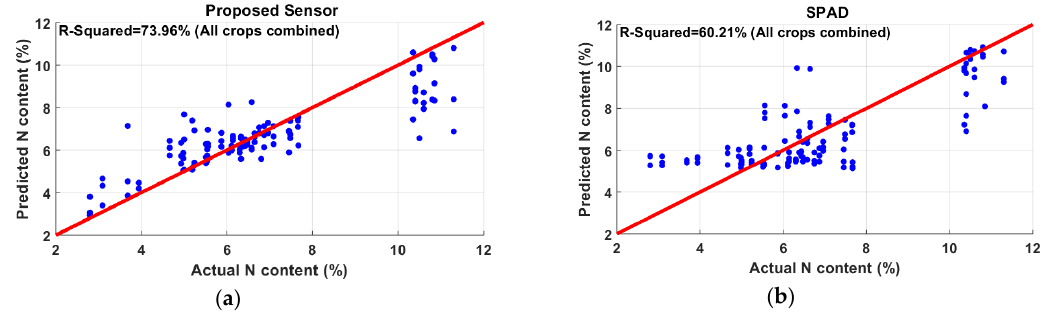
Figure 14. Comparison between ( a ) proposed sensor and ( b ) soil plant analysis development (SPAD). The proposed sensor showed a better correlation (73.96%) with N than SPAD (60.21%).